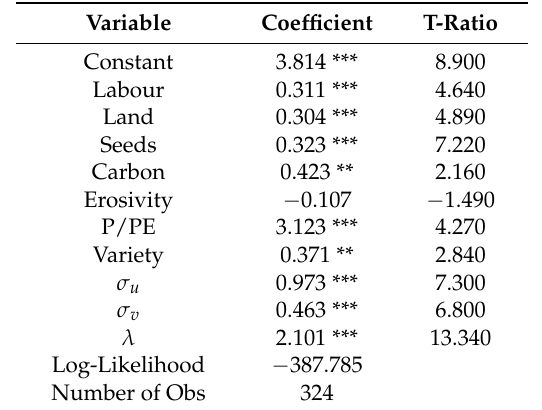
Table 2. Coefficient estimates for parameters of the Cobb-Douglas production frontier.